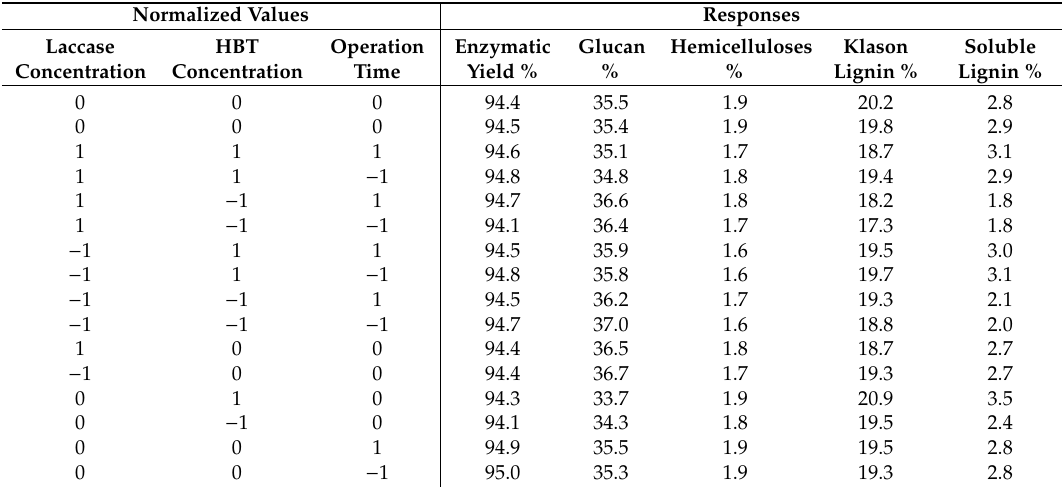
Table 2. Results for autohydrolysis + enzymatic yield, glucan, hemicelluloses, and lignin contents in solid phase after the treatment with laccase. Normalized values of independent variables ( X l : laccase concentration; X m : 1-hydroxybenzotriazole (HBT) concentration, and X t : operation